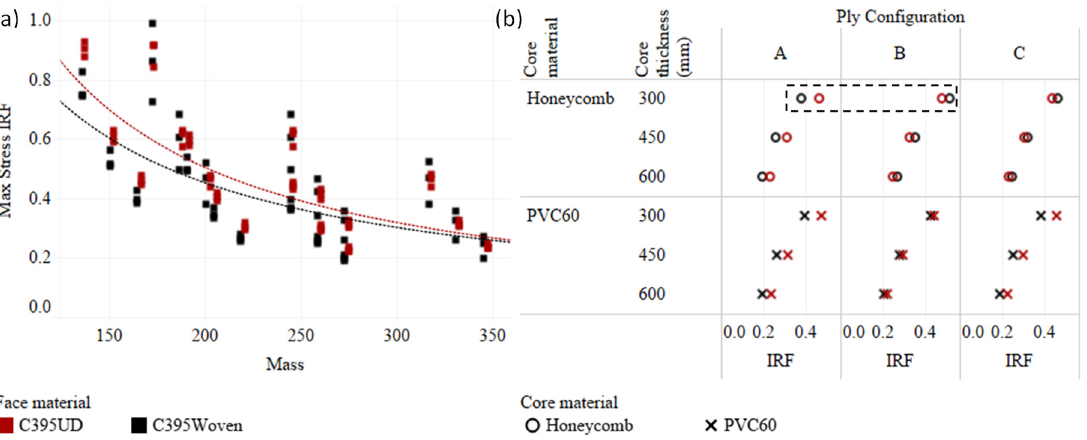
Figure 21. ( a ) Comparison of strength performance between UD and woven fibres. ( b ) The black box shows the preference for UD or woven is dependent on the ply configuration.